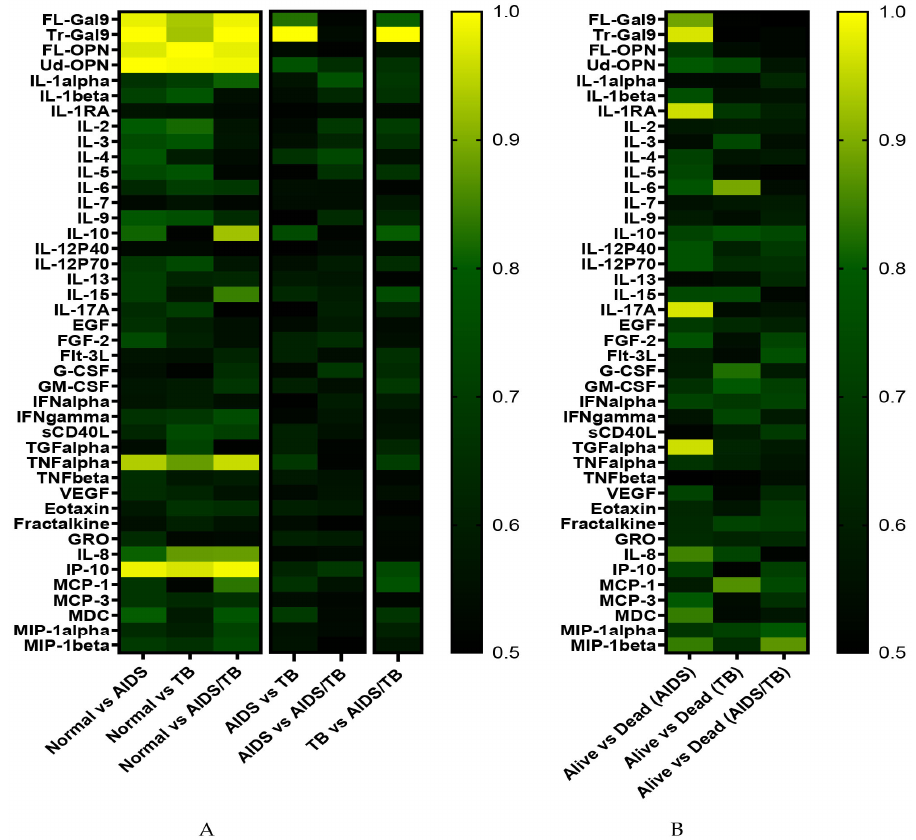
Figure 3. Fluctuations in matricellular proteins and cytokines / chemokines in the plasma of AIDS, TB, and AIDS / TB patients. Indicated groups were compared using ROC curve analysis. Heat maps were generated using the AUC values to identify plasma factors that may be useful for diagnosis. Comparison among normal subject, AIDS, TB, and AIDS / TB patients ( A ), or between living and deceased patients ( B